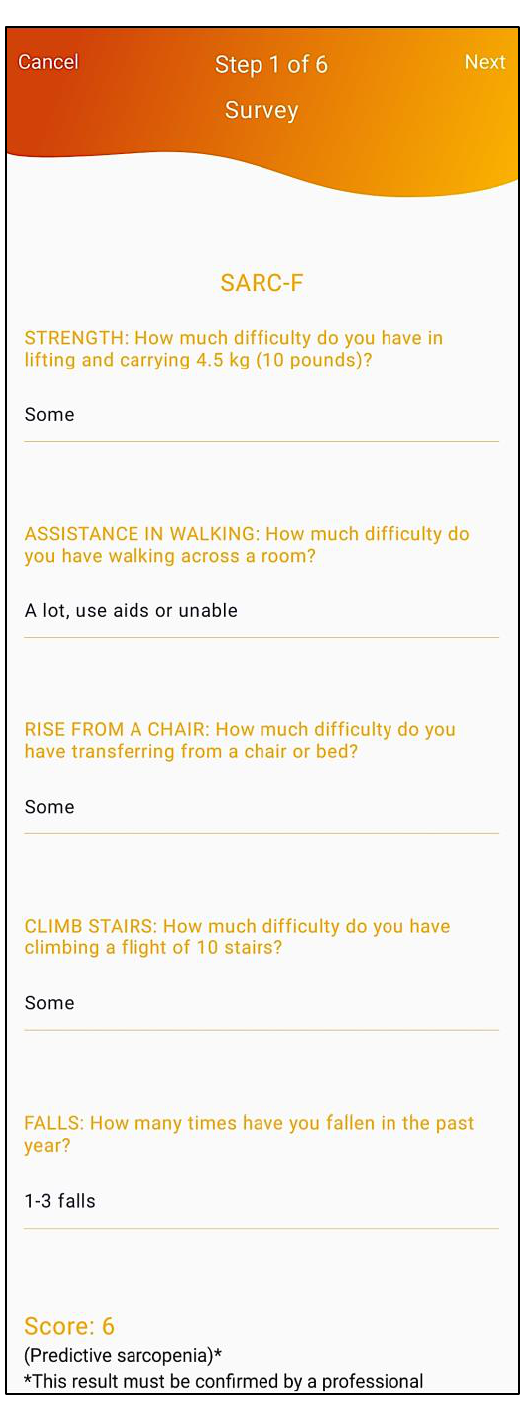
Figure 3. Application of the SARC-F questionnaire.